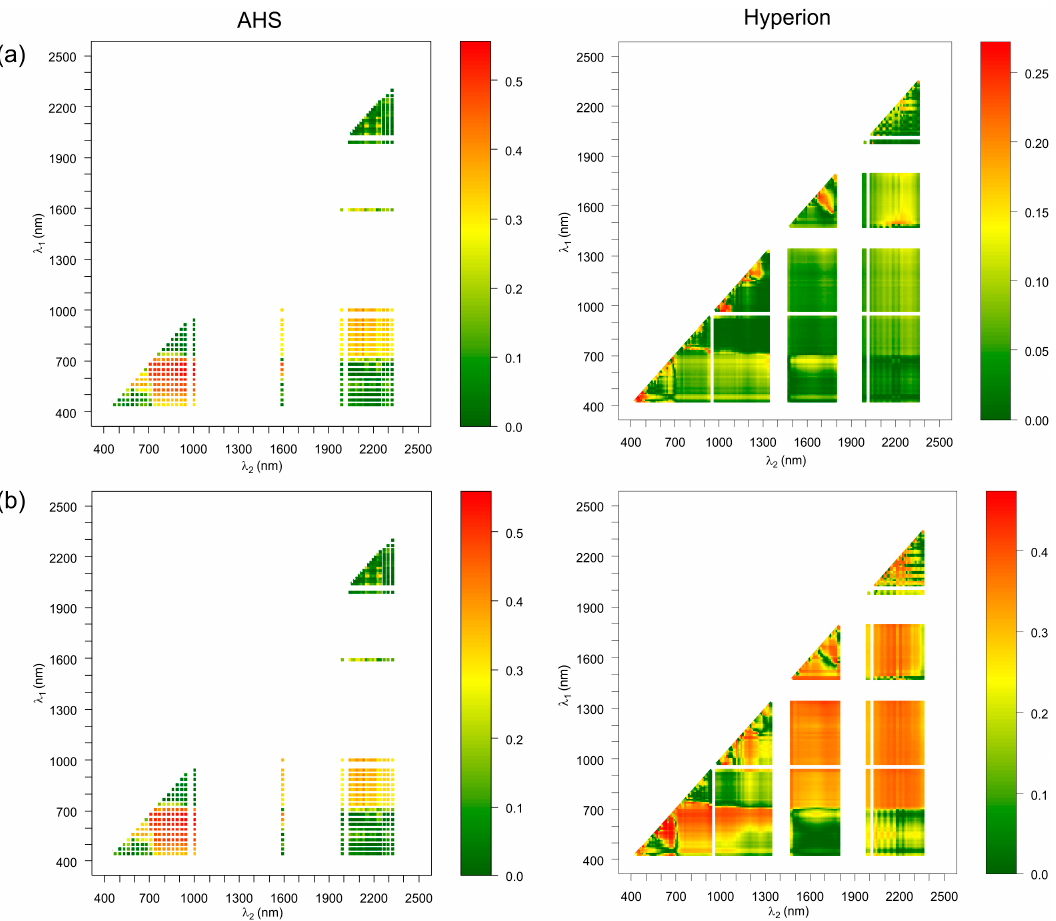
Figure 4. Coefficient of determination R 2 between the TOC ( a )/OC content ( b ) and the spectral indices SI λ 2 −λ 1 = ( ρ λ 2 − ρ λ 1 )/( ρ λ 2 + ρ λ 1 ), based on AHS ( left ) and Hyperion ( right ) reflectance values. R 2 values in the graphs are symmetric with respect to the 1:1 line, and therefore λ 1 and λ 2 can be used interchangeably.